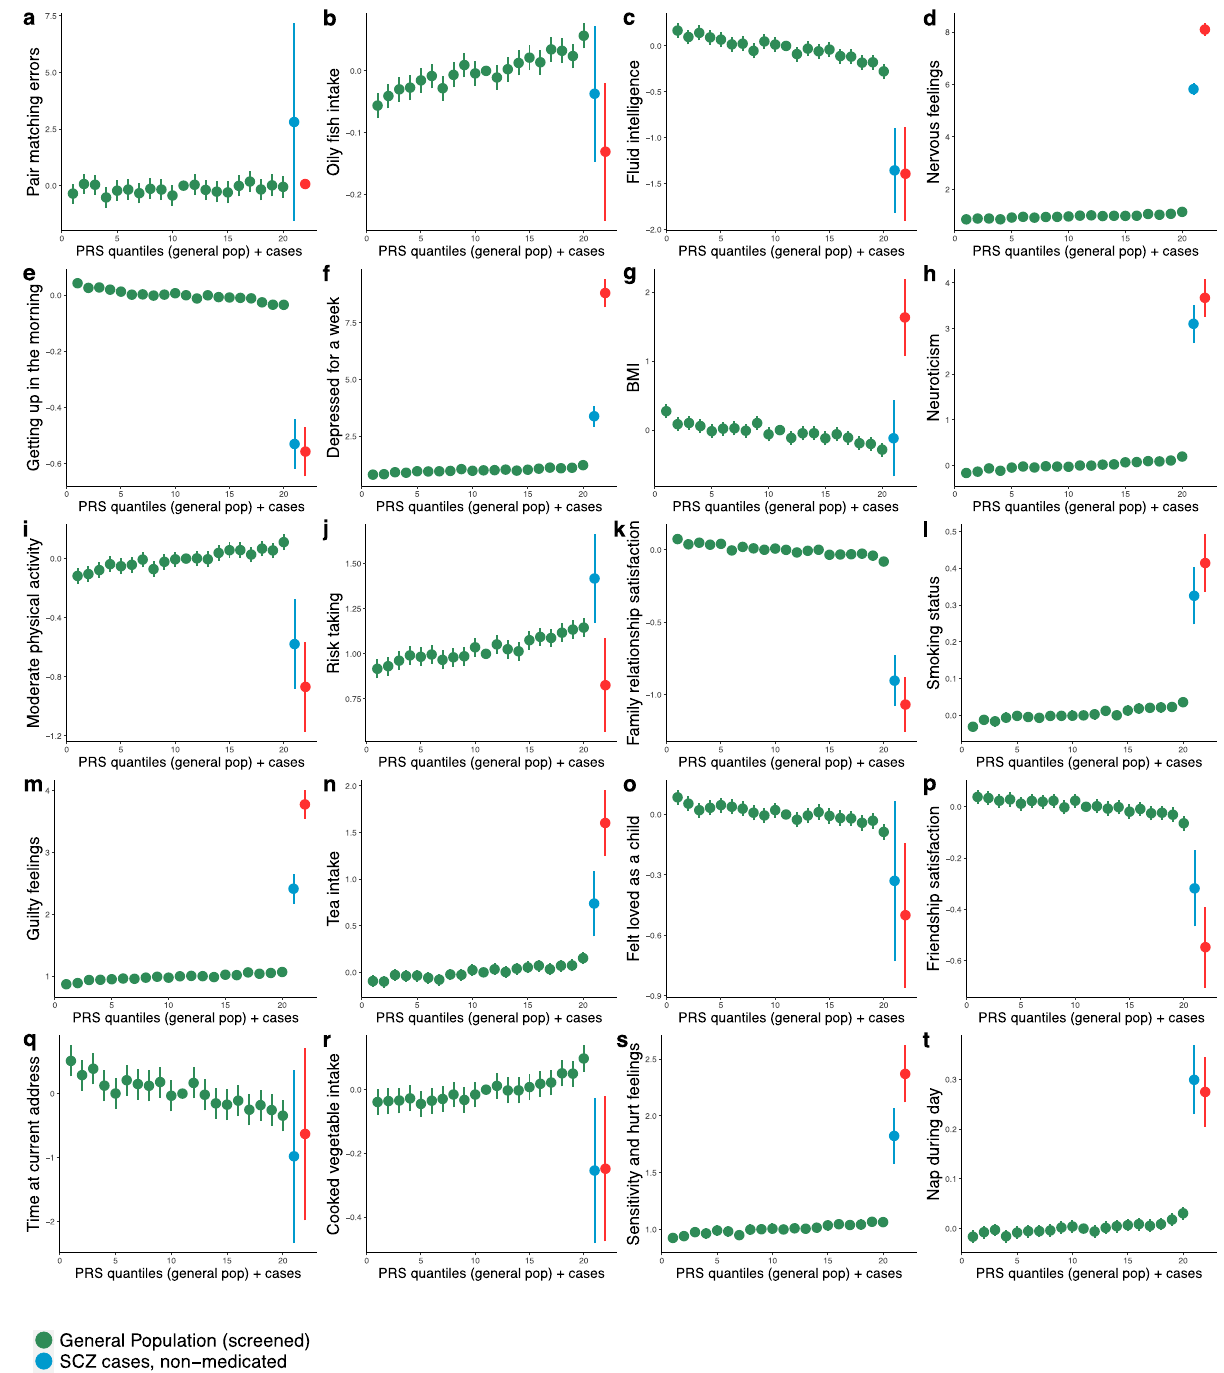
Fig. 2 PRS-by-trait quantile plots (in green) indicating the trends of association between the best- fi t schizophrenia PRS and the target behavioural traits among 20 of the most signi fi cant associations, matching those of Fig. 1. The quantile plot is ordered along the x -axis from low to high genetic risk for schizophrenia, according to PRS in the target (UK Biobank) data, with each green point representing the average target trait value of a 5% quantile of the sample. The y -axis shows the regression coef fi cients corresponding to the effects of the PRS on the trait, controlled for covariates (see Methods). Non-medicated (blue) and medicated (red), at baseline, diagnosed individuals are appended to the right end of each plot, re fl ecting the expected higher genetic burden of diagnosed individuals compared to unaffected individuals (see Main Text). Vertical lines represent 95% con fi dence intervals; these appear absent for some traits with a large range and are larger in the two categories of cases due to their smaller sample